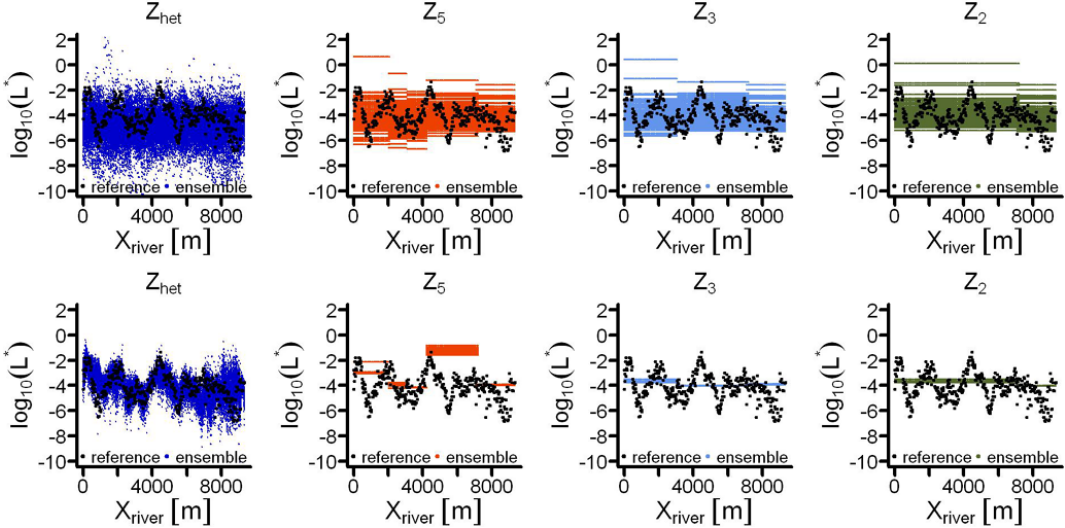
Fig. 10. Ensembles of leakage coefficients (coloured) and reference field (black) along the river reach at day 1 (upper row) and at day 600 (lower row) for scenario A. Distance X river is calculated starting from the two most western river nodes. L ∗ has units m s − 1